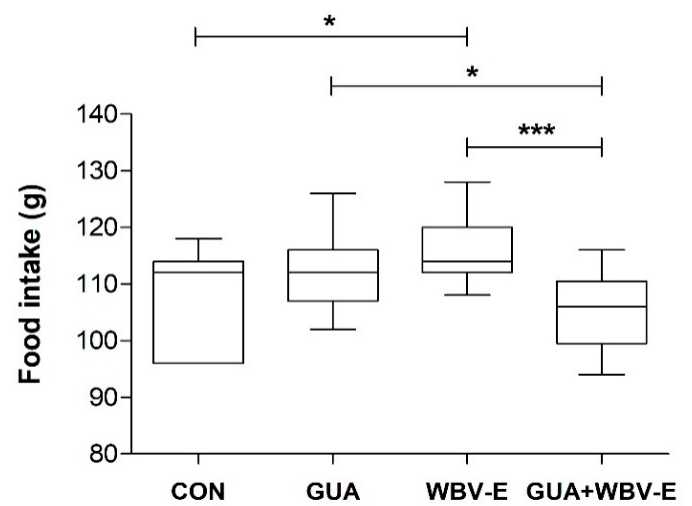
Figure 4. Food intake (g) of animals exposed to different treatments (CON, control; GUA, group treated with guarana; WBV-E, group exposed to mechanical vibration generated in platform, GUA + WBV-E, group treated with guarana and exposed to mechanical vibration). Adjusted p values (Kruskal–Wallis) were considered significant at * p < 0.05, ** p < 0.01, and *** p < 0.001. Table 1. %ATI/g of the Na 99m TcO 4 from organs isolated from the rats submitted to some interventions.